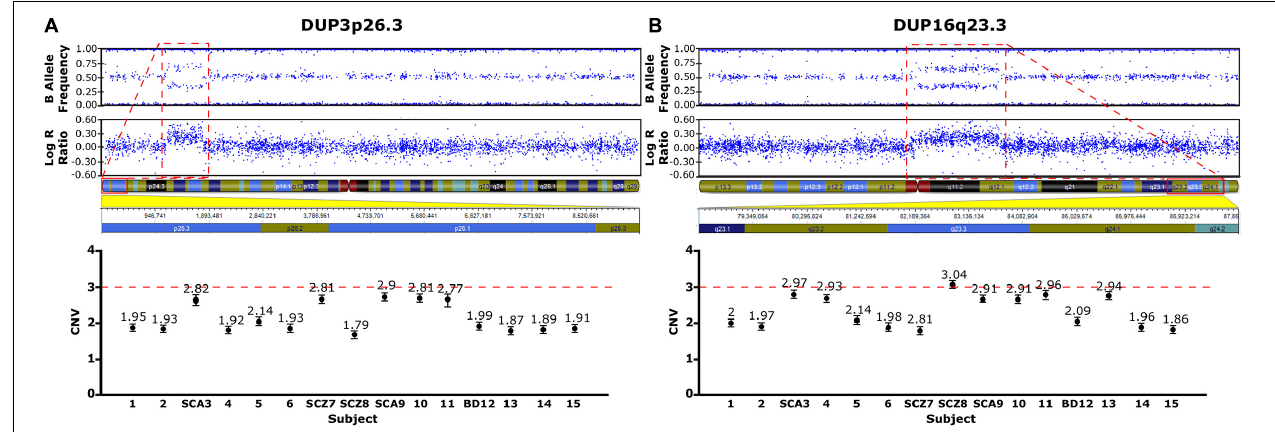
FIGURE 2 | CNVs Identified in the Family Pedigree Associated with Psychosis. Upper panels, CNVs detected using the cnv Partition algorithm, based on the B allele frequency and the log R ratio (LRR: logarithm of the observed/expected probe intensity). Duplications identified (red rectangles), 3p26.3 (A) and DUP16q23.3 (B) are defined by allele frequencies of 0.33 and 0.66. The genetic map of the genomic regions containing the duplications are shown below with the affected genes highlighted in red. Lower panels, CNVs validated by ddPCR. Values close to 3 are indicative of a duplication (A,B) .